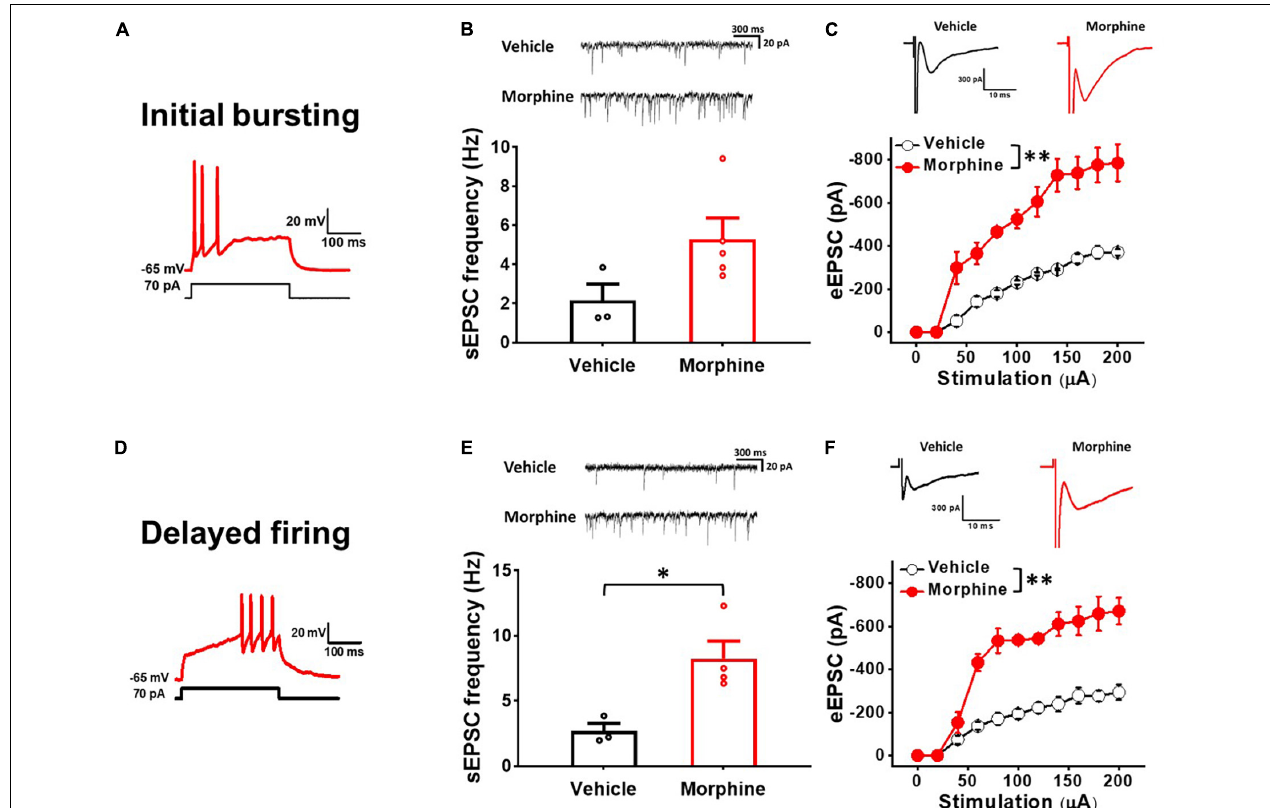
FIGURE 2 | Repeated morphine treatment increased excitatory synaptic strength in non-tonic firing (Initial bursting and Delayed) neurons in the SDH. (A) Representative trace of initial bursting neurons. (B) (top) Representative traces of spontaneous excitatory postsynaptic current (sEPSC) and (bottom) sEPSC frequency in initial bursting neurons (effect size: 1.47, p = 0.063; Vehicle: N = 3, n = 16; Morphine: N = 5, n = 36). (C) (top) Representative traces of eEPSC in initial bursting neurons and (bottom) stimulus-responsive curve of eEPSC ( F ( 1 , 29 . 13 ) = 211.78, p < 0.001; Vehicle: N = 3, n = 13; Morphine: N = 3, n = 8). ∗∗ p < 0.01 vs. vehicle by Sidak’s multiple comparison test following multilevel analysis. (D) Representative trace of delayed firing neurons. (E) (top) Representative traces of sEPSC and (bottom) sEPSC frequency in delayed firing neurons (effect size: 2.50, p = 0.020; Vehicle: N = 3, n = 7; Morphine: N = 4, n = 11). ∗ p < 0.05 by Welch’s t